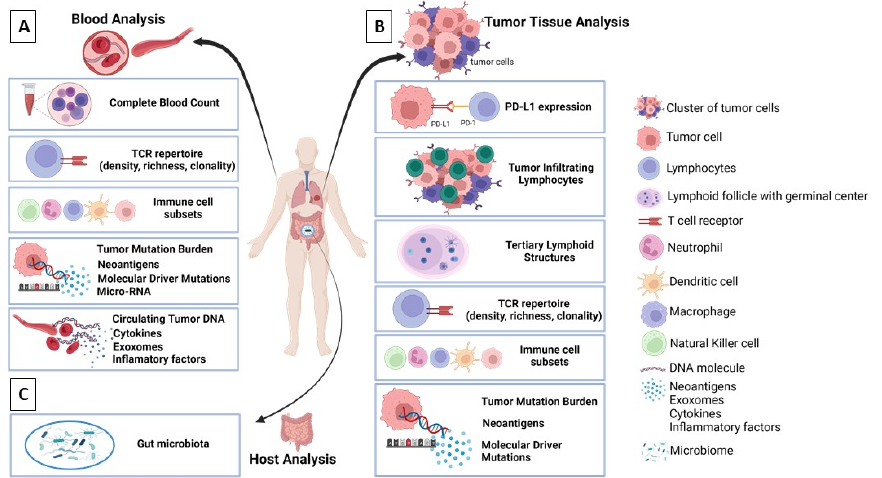
Figure 4. Biomarkers used for assessment of response to neoadjuvant immunotherapy and patient monitoring in resectable NSCLC. Biomarkers grouped by source: ( A ) blood, ( B ) tumor tissue, and ( C ) stool. PD-L1, programmed cell death-ligand 1; PD-1, programmed cell death-1; TCR, T cell receptor. Graphic created using Biorender (http://biorender.com, access date 27 April